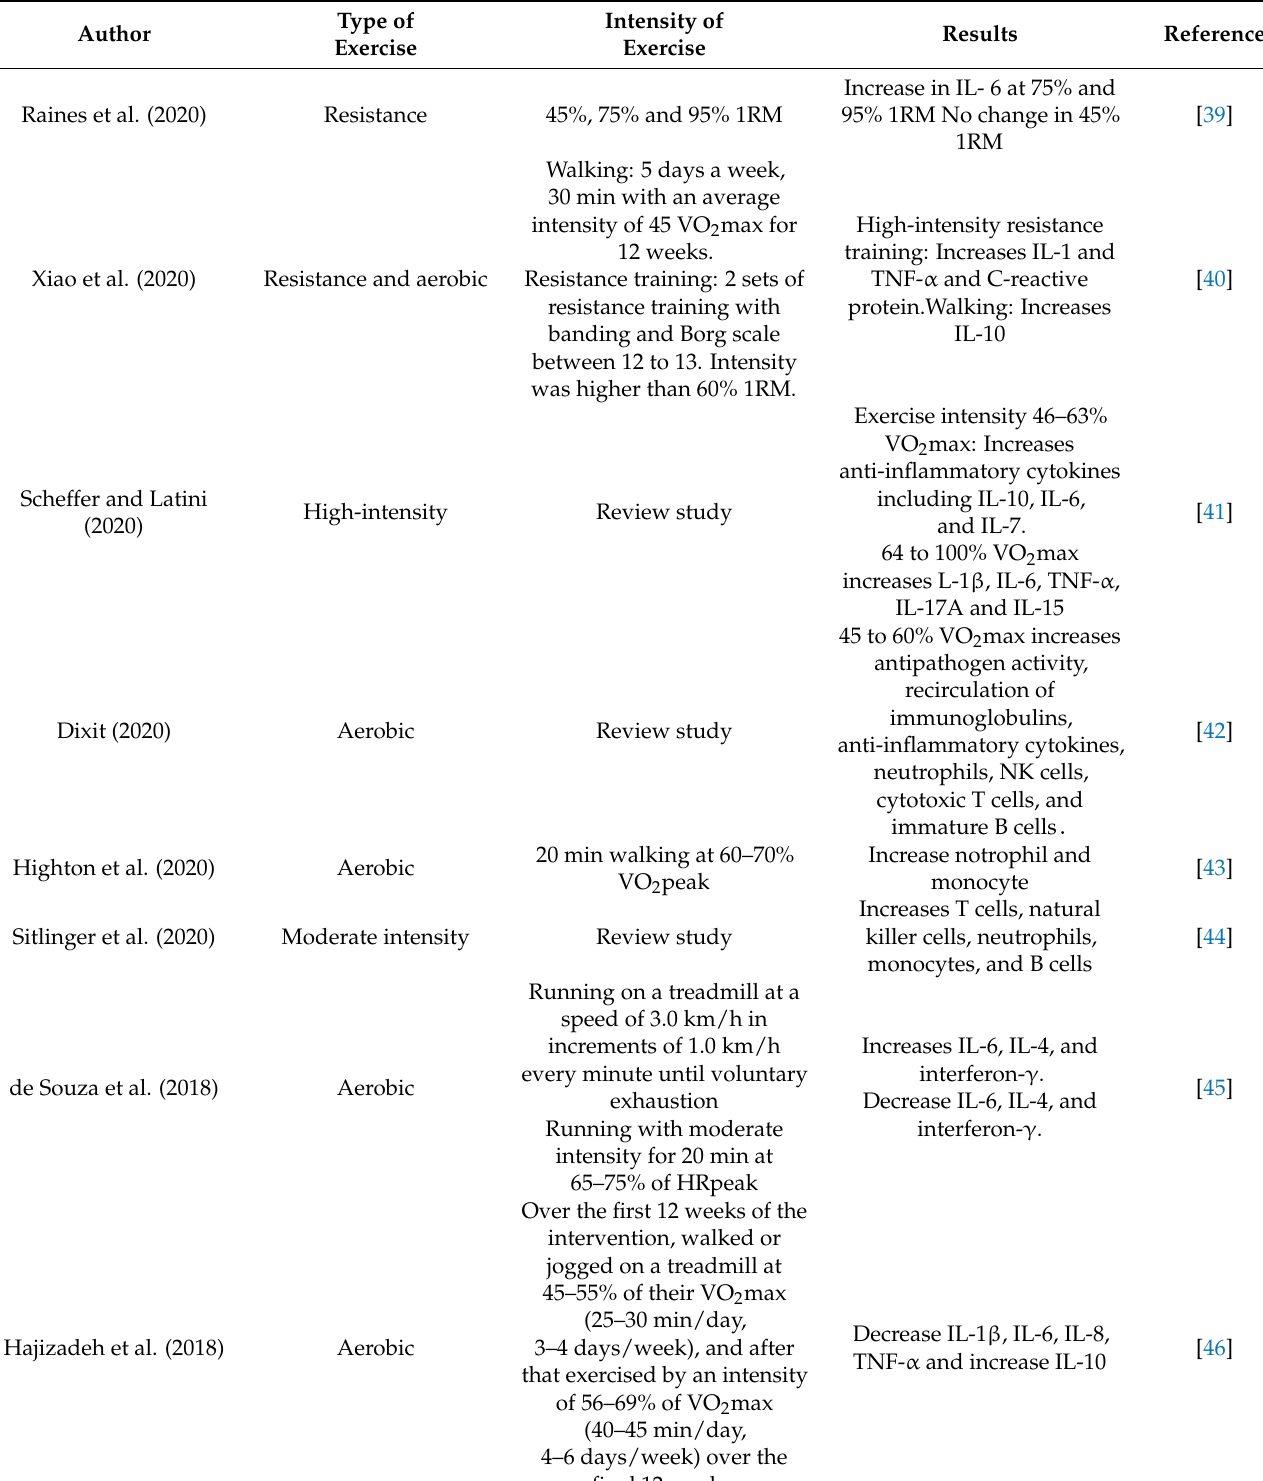
Table 2. Effect of different intensities of exercise on immune